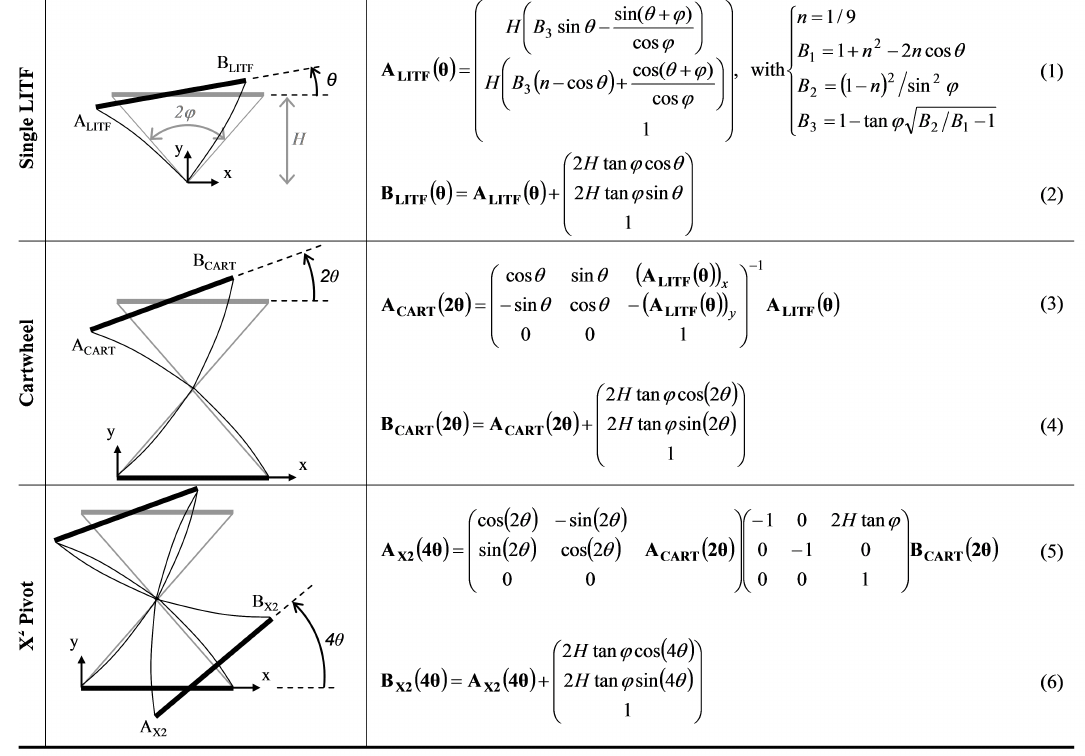
Figure 9. Theoretical trajectories of the vertices for the leaf-type isosceles-trapezoidal flexural (LITF), cartwheel and X 2